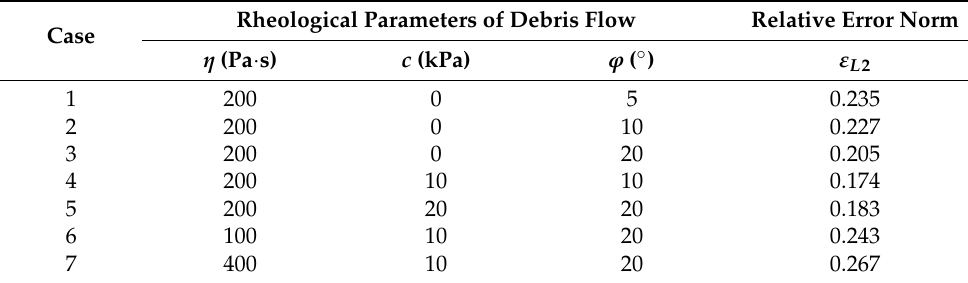
Table 1. L 2 relative error norm in the deposition